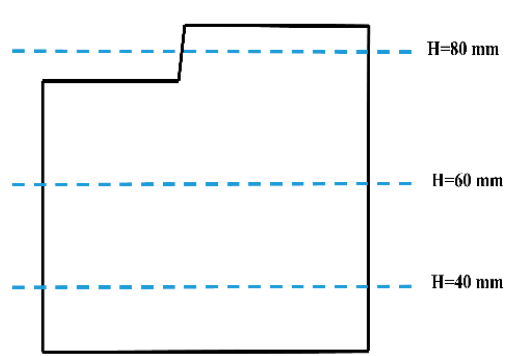
Figure 23. Layers used to compare numerical and experimental results for the stub-hole Figure 25. Layers used to compare numerical and experimental results for the stub-hole geometry.